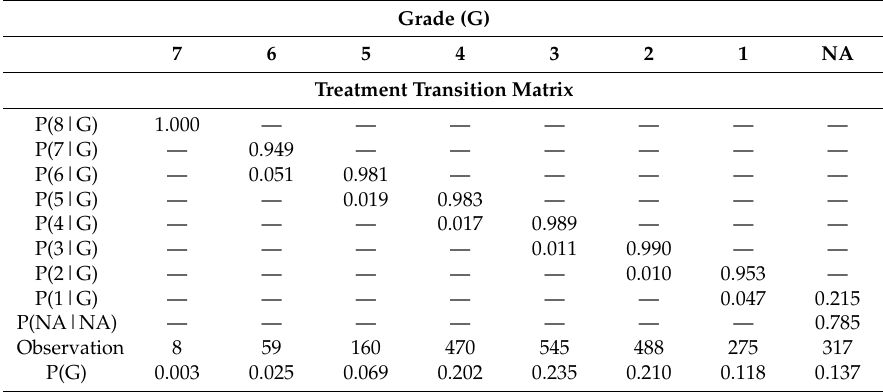
Table A4. Transition matrices (ages